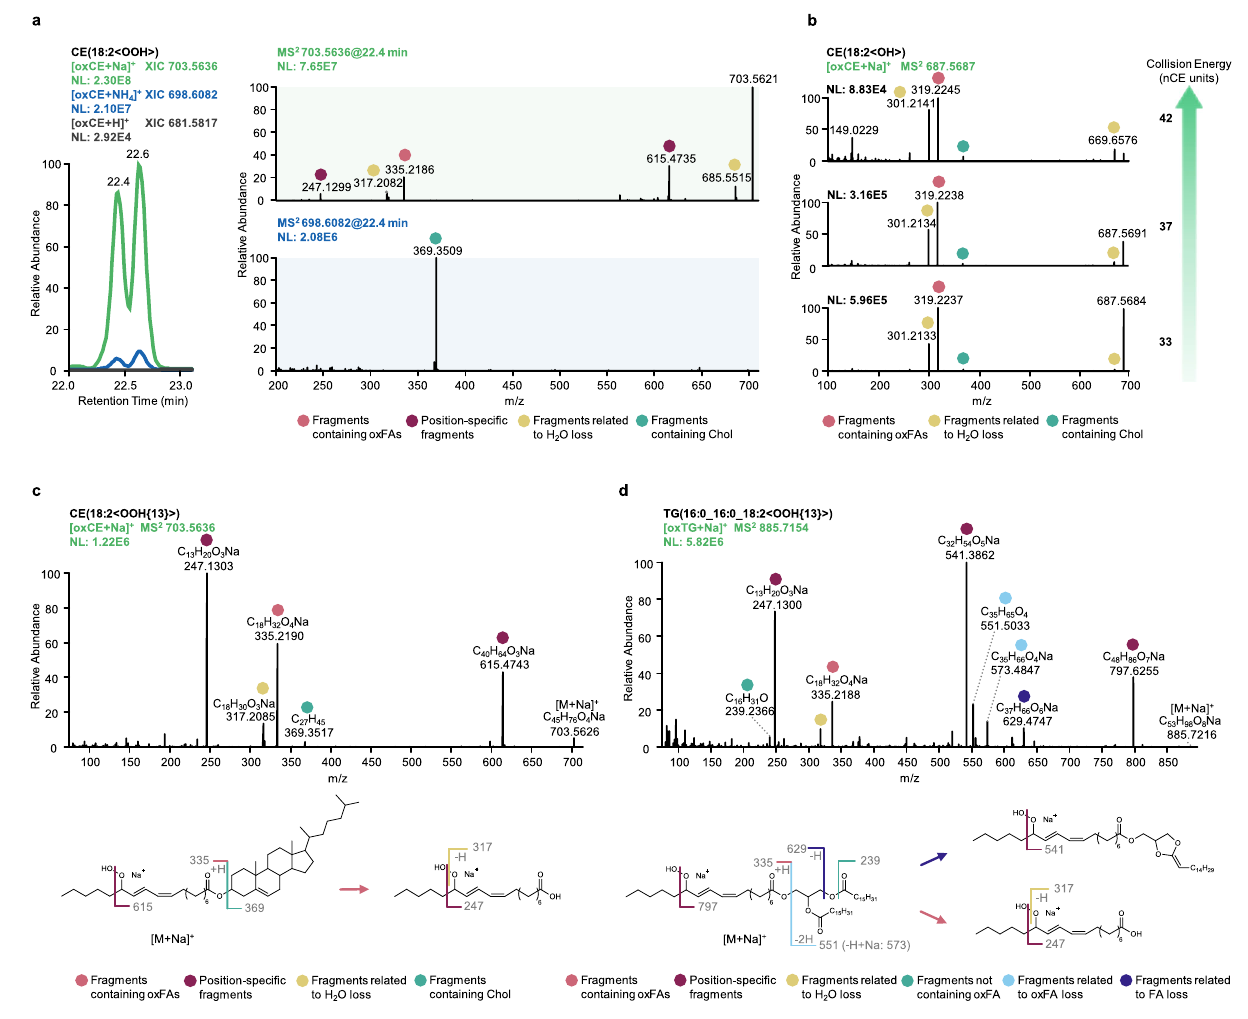
Fig.2|OptimizationofelevatedenergyHCDofsodiatedprecursorstosupport structuralelucidationofoxidizedneutrallipids. Utility of tandem mass spectra to provide structure-relevant fragment ions was compared for protonated (gray), ammoniated (blue) and sodiated (green) oxCE precursor ions ( a ). Considering larger numbers of structure-relevant fragment ions obtained by HCD of sodiated